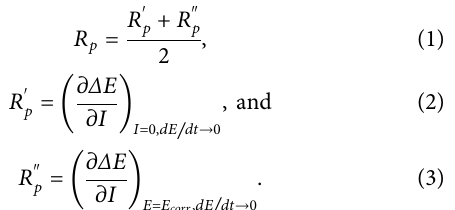
Frontiers in Materials |